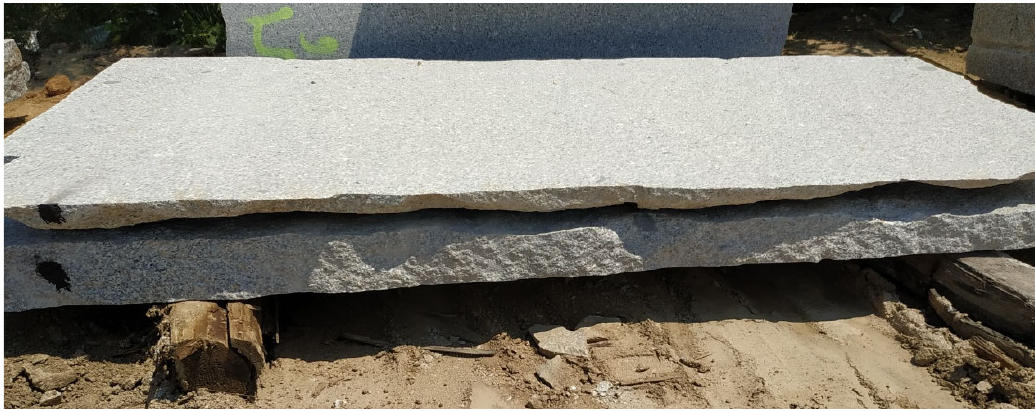
Table 1. Characteristics of waste from the processing of natural stone.